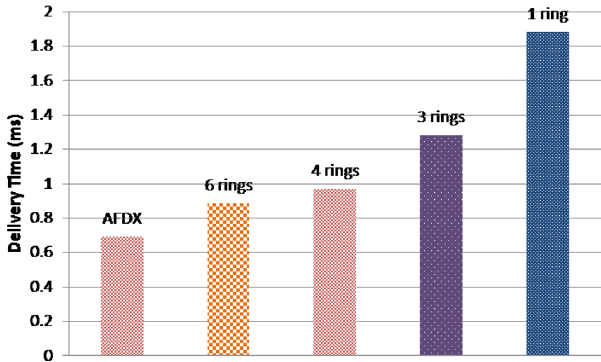
Figure 18. Maximum delivery times for traffic class